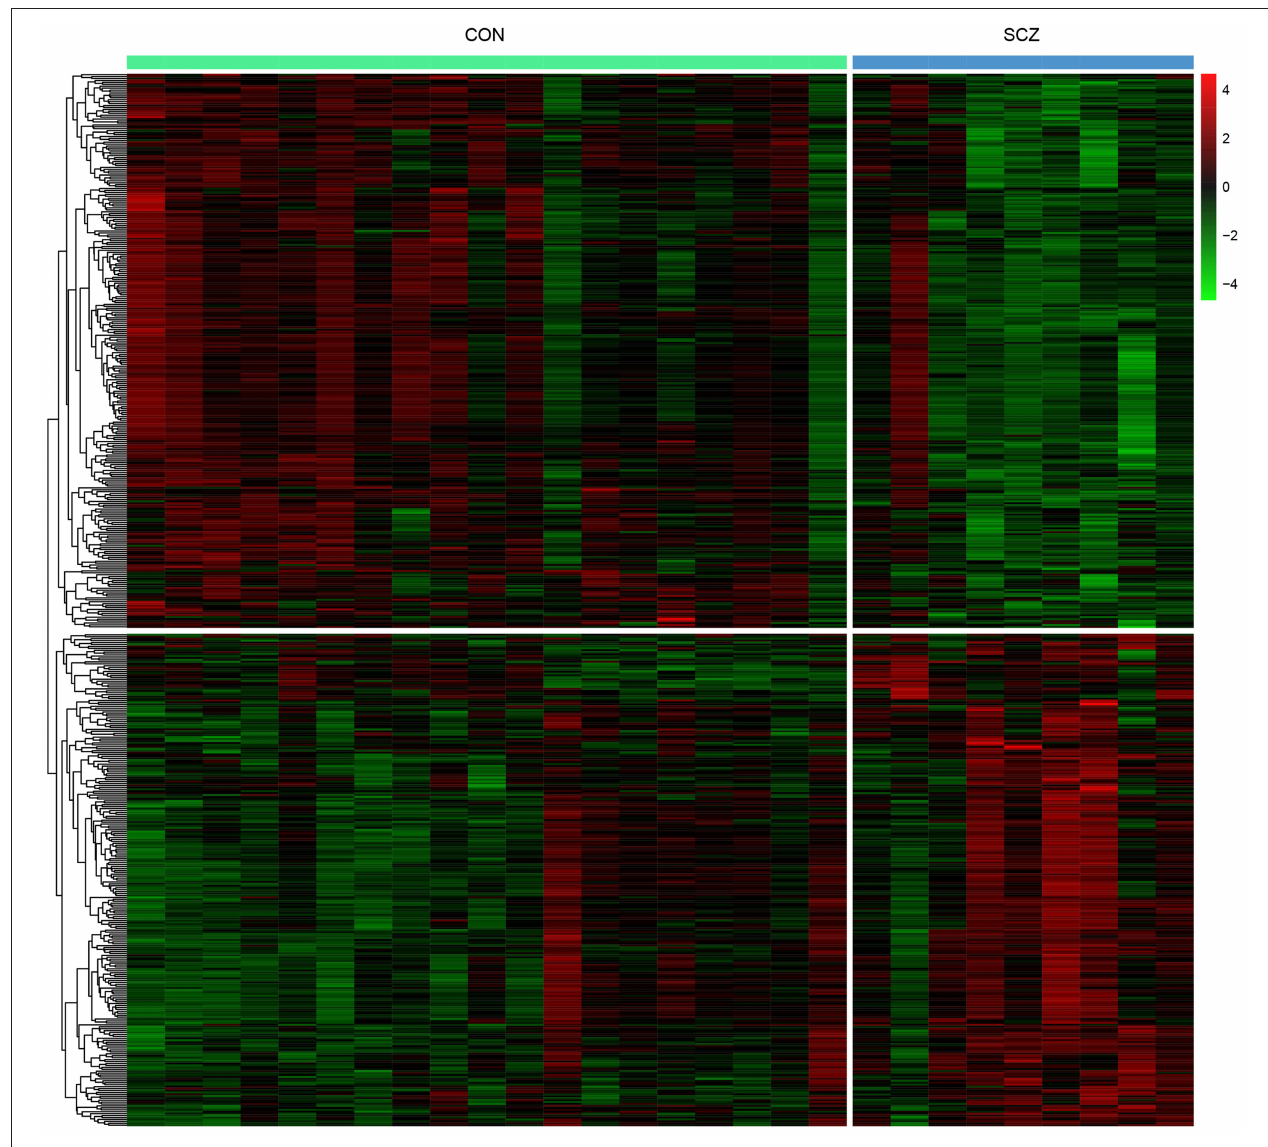
FIGURE 1 | Heat map of DEGs in